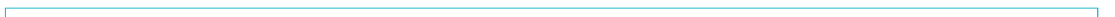
Figure 1: A. Incomplete continuous wave (CW) Doppler spectral wave envelope leading to peak tricuspid regurgitation velocity (TRV) under- estimation (3.69 m/s). B. same patient after correct adjustment of CW Doppler in TR jet with correct TRV estimation (4.15 m/s). C. Inadequate CW gain with “fringes” and peak TRV overestimation (pink cross: 5.62 m/s); correct peak TRV estimation in modal frequency (4.69 m/s). D and E. Inferior vena cava (IVC) size during expiration and “sniff” in the same patient. SPAP = systolic pulmonary arterial